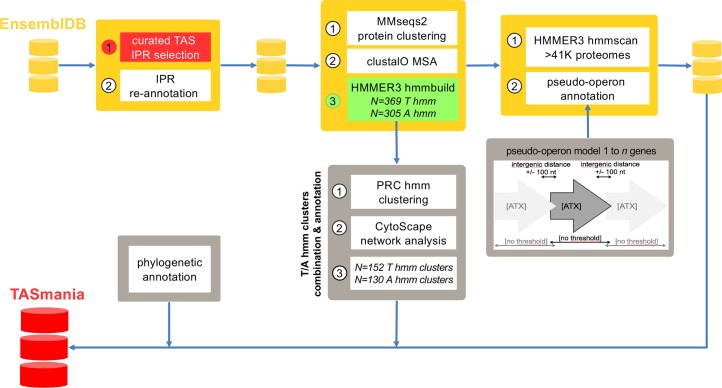
Overview of the pipeline to build the TASmania database.The different steps include: downloading EnsemblBacteria, updating the InterPro annotation, selecting the proteins matching an arbitrary list of reference TAS IPR, building the corresponding HMM profiles and scanning the proteomes. In parallel, we structure target genomes into pseudo-operons and include phylum information. Finally, we add extra value to TASmania by clustering the HMM profiles into larger families for TA combinations analysis.